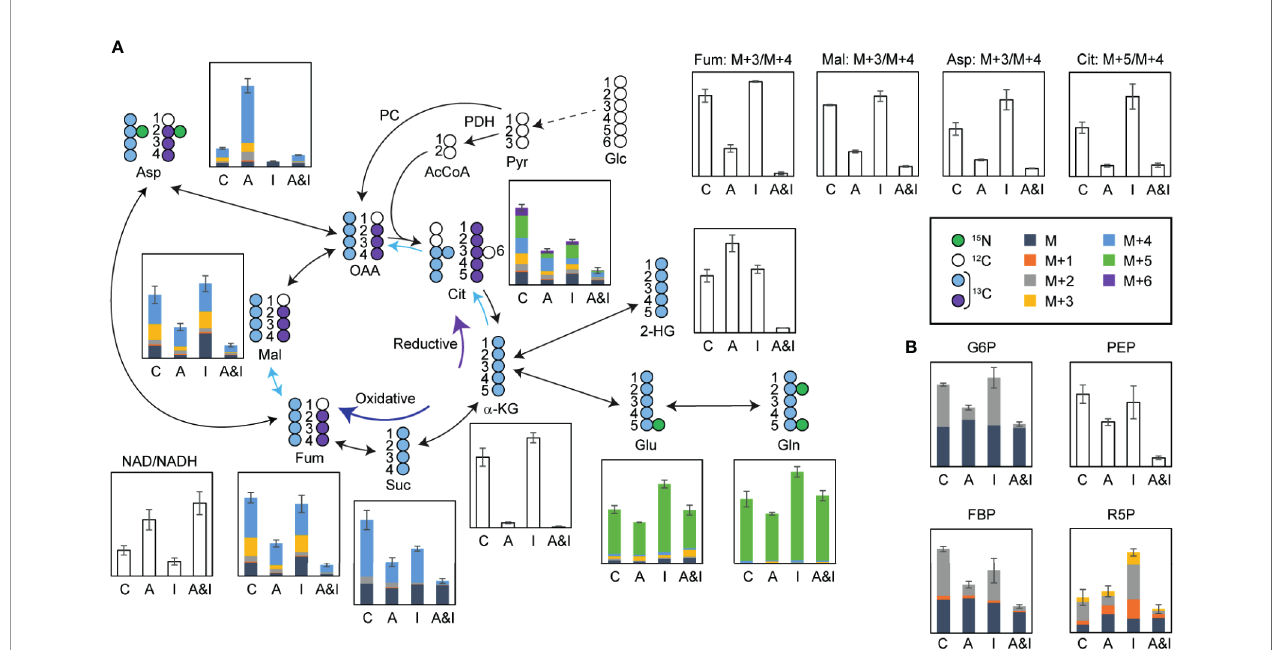
FIGURE 5 | In-depth metabolic fl ux analysis and data mining reveal that extensive disruption of cells metabolism following treatment contributes to the synergy between IACS-010759 and AC220. U937 cells were treated with 500 nM AC220 and/or 5 nM IACS-010759 for 24 h. Relative metabolite levels are overlayed on a schematic representation of the fl ux of isotopically labeled (A) glutamine ( 13 C 5 , 15 N 2 -glutamine) through the TCA cycle or (B) 1,2- 13 C 2 -glucose through glycolysis and pentose phosphate pathway. Blue arrows highlighting speci fi c TCA cycle reactions indicate metabolic reactions with Cohen ’ s d-values lower than -0.8. Shaded bars show 13 C enrichment fractions; empty bars show total pool intensities or total pool intensity ratios, or isotope intensity ratios (average of three replicates). Error bars represent standard deviations (n=3). C, control; A, AC220; I, IACS-010759; A&I, AC220+IACS-010759; Glc, glucose; Pyr, pyruvate; PDH, pyruvate dehydrogenase; AcCoA, acetyl CoA; PC, pyruvate carboxylase; OAA, oxaloacetate; Cit, citrate; a -KG, alpha-ketoglutarate; Glu, glutamate; Gln, glutamine; Suc, succinate; Fum, fumarate; Mal, malate; Asp, aspartate; NAD, oxidized form of nicotinamide adenine dinucleotide; NADH, reduced form of nicotinamide adenine dinucleotide; G6P, glucose 6-phosphate; PEP, phosphoenolpyruvate; FBP, fructose 1,6-bisphosphate; R5P, ribose